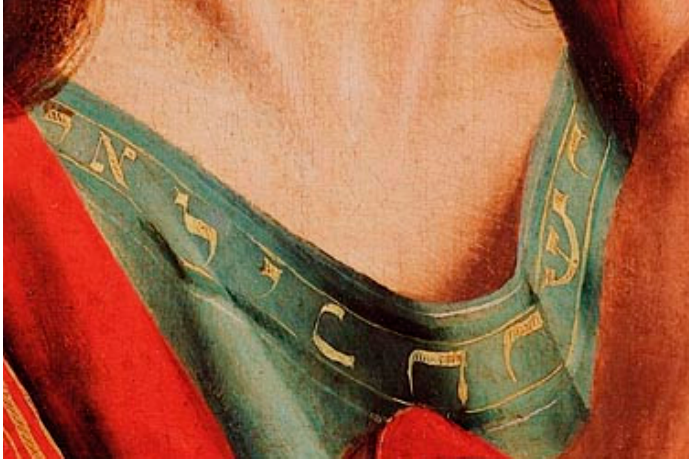
Figure 10. Quentin Massys? Jan Massys? Christ blessing (detail), 1528-38. Winterthur, Kunstmuseum Winterthur. Courtesy of the Kunstmuseum